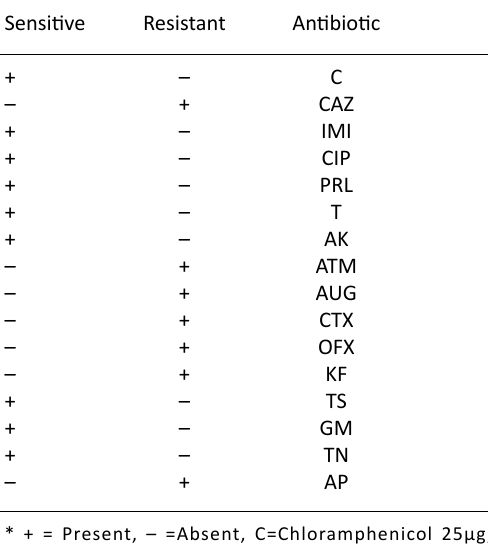
Table 2. Antibiotic profile of